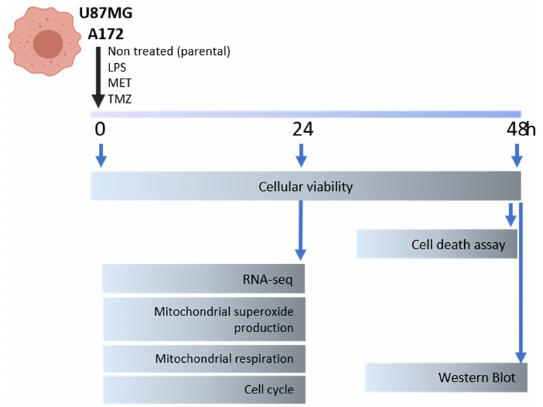
Figure 1. The schematic presentation of the experimental